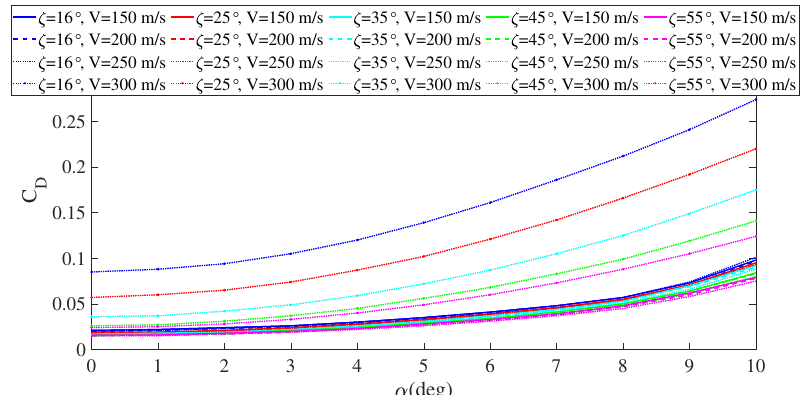
Figure 5. The drag coefficients C D for different conditions of V and ζ under h = 7000 m.